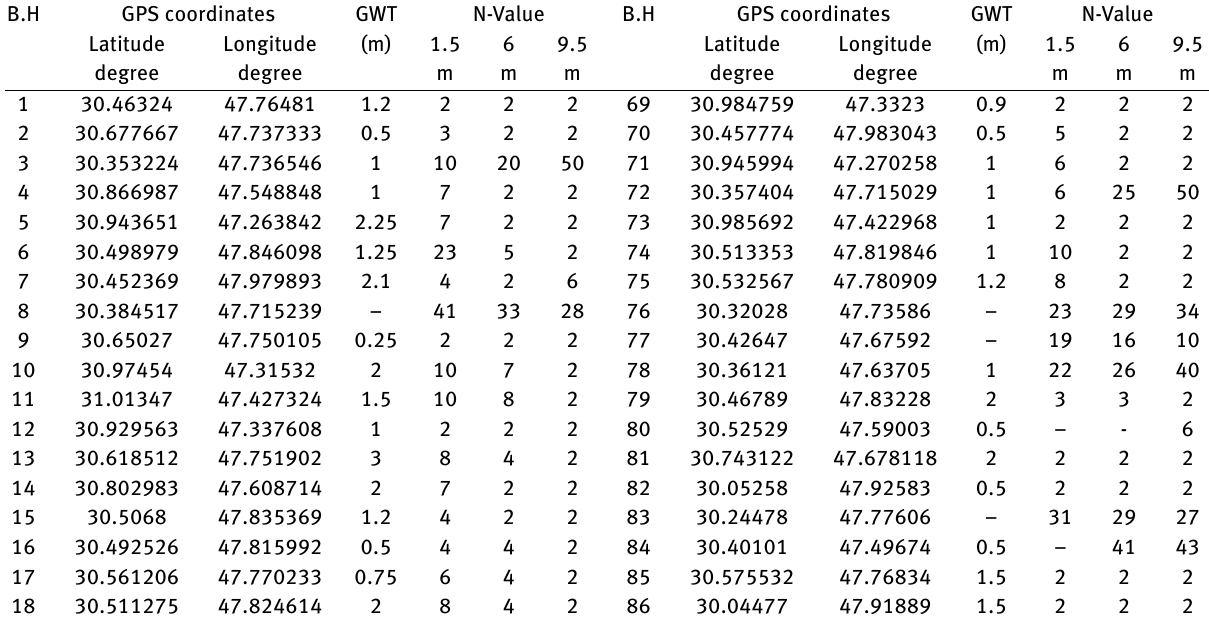
Table 1: Coordinates, GWT, and measured SPT-value of boreholes